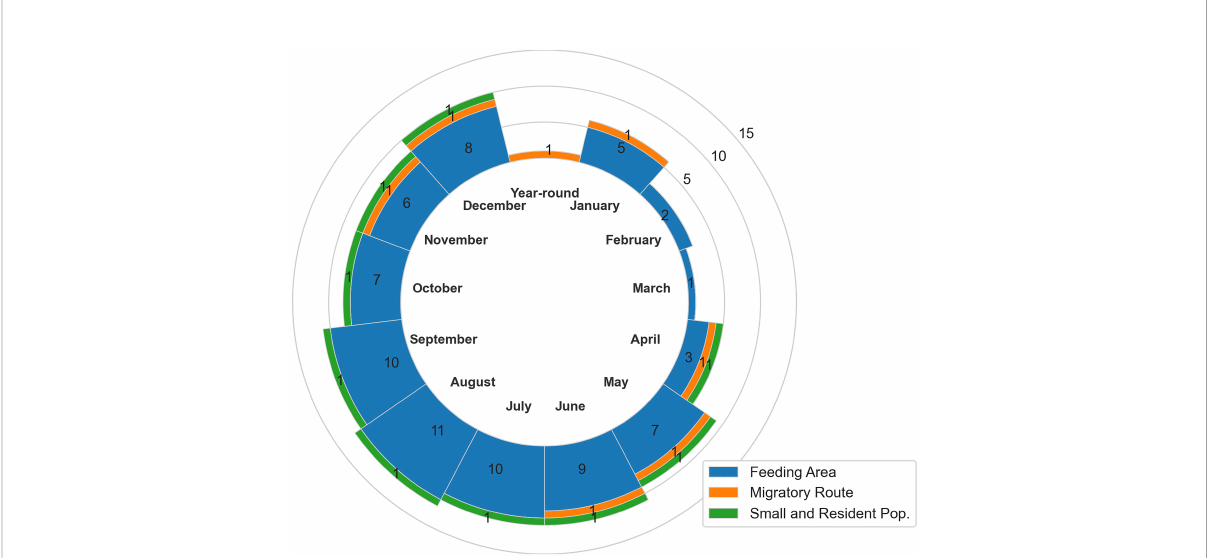
FIGURE 10 Aleutian Islands and Bering Sea region seasonality of BIAs by month and BIA type. The number of BIAs includes the hierarchical BIA parent only and does not include the child